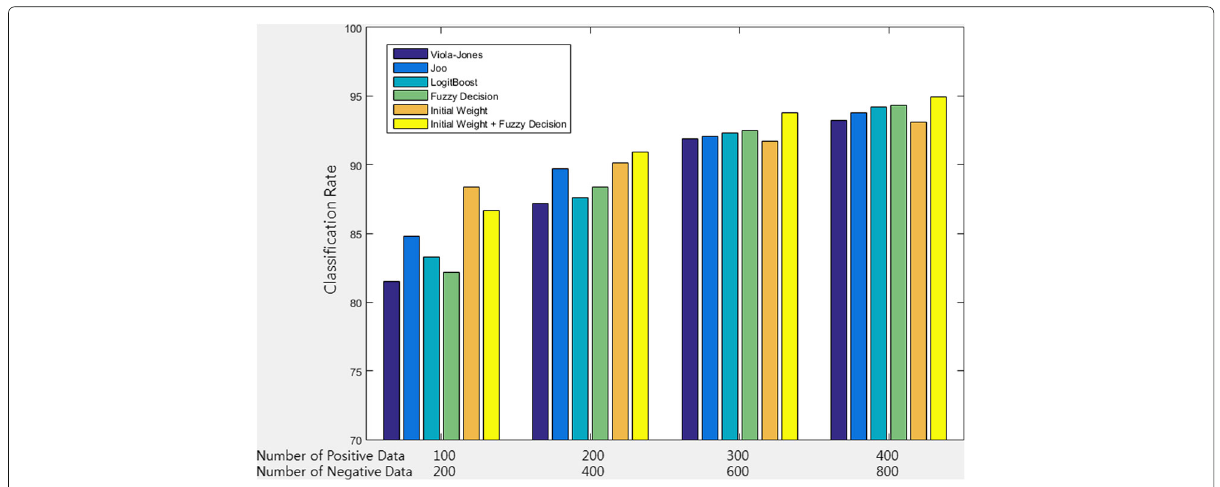
Fig. 9 Correct classification rate along the size of training data